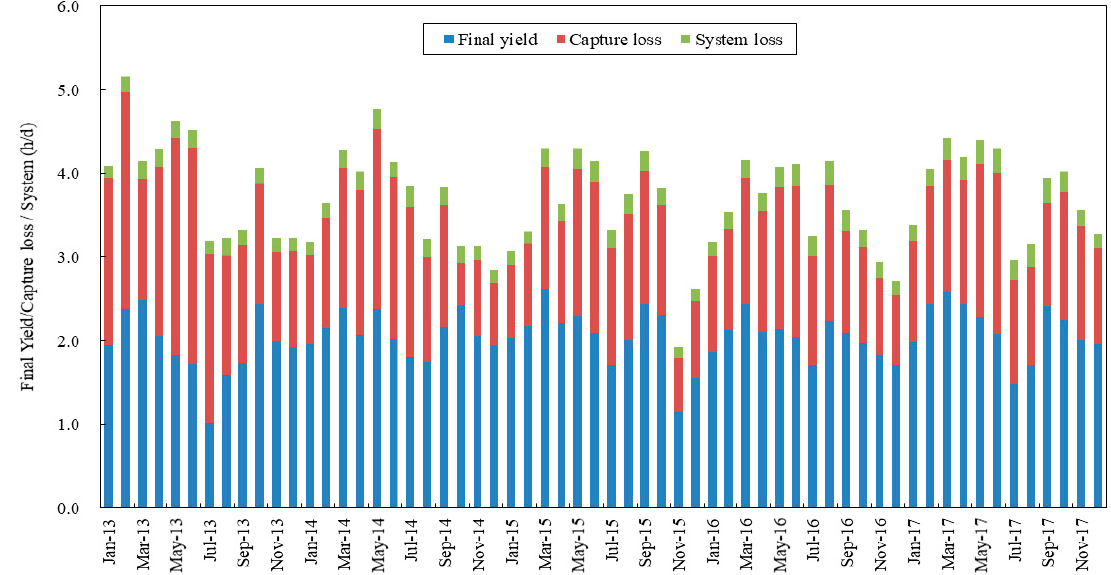
Figure 7. Average monthly final yields, capture losses, and system losses of the entire BIPV system.